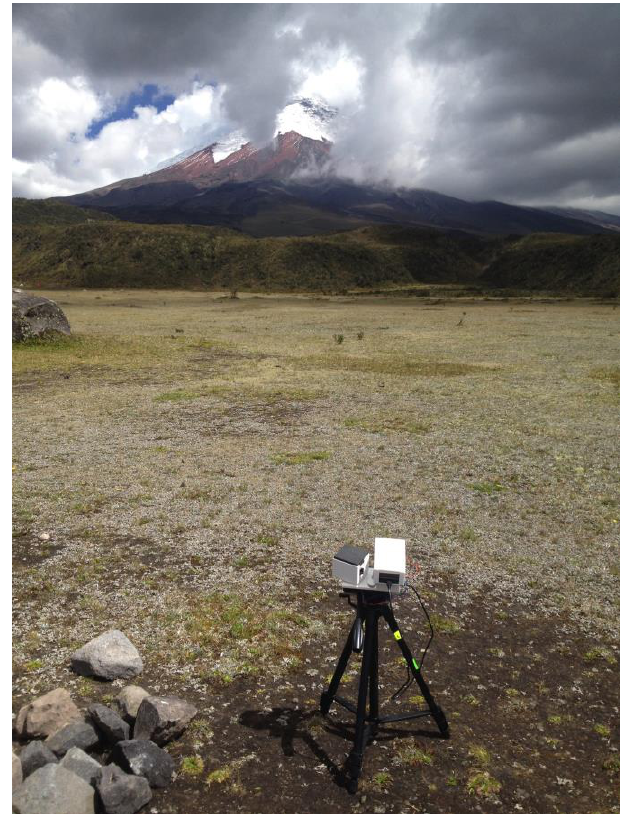
Figure 5. Raspberry Pi camera-based spectrometer applied to measurements of sulphur dioxide gas release from Cotopaxi volcano, Ecuador.